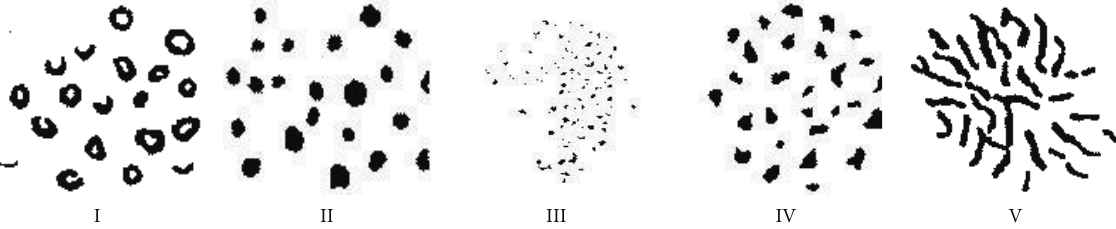
Figure1:LeGal’sMCsclassificationstandards.TypeI:annular;TypeII:regularlypunctiform;TypeIII:dusty;TypeIV:irregularlypunctiform; Type V: vermicular